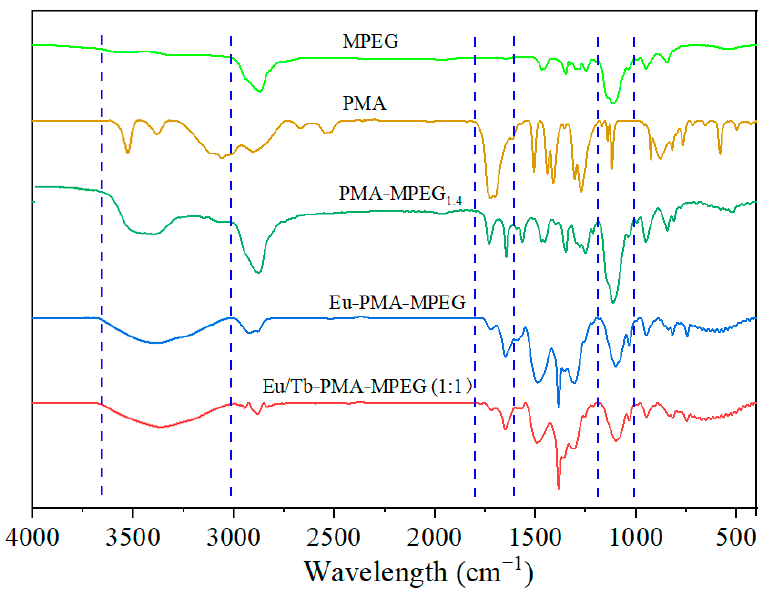
Figure 2. FT IR spectra of MPEG, PMA, PMA-MPEG 1.4 , Eu-PMA-MPEG and Eu/Tb-PMA-MPEG (Eu/Tb = 1:1).